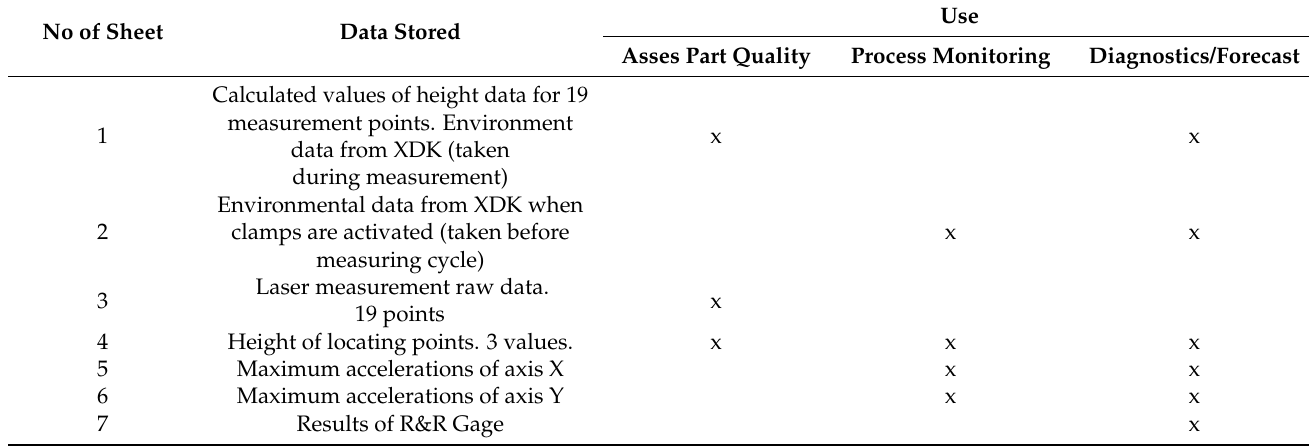
Table 1. Description of contents of Google spreadsheet. Signals that are transferred to the Cloud, as well as their intended use. No of Sheet Data